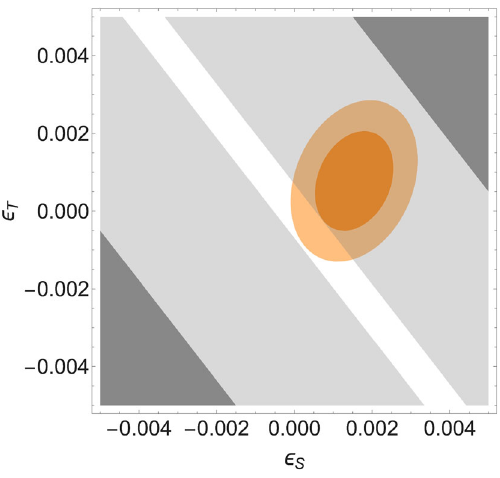
Fig. 3 Constraints on the Wilson coefficients (cid:15) S and (cid:15) T in the quark- level Lagrangian Eq. (2.5) at the scale μ (cid:16) 2 GeV, assuming ˜ (cid:15) X = 0 and marginalized over the remaining Wilson coefficients. We show the region preferred by the combination of low-energy precision measure- ments performed in Ref. [50] at 68% CL (darker orange), and 95% CL (lighter orange). We also show the region excluded by a hypothetical measurement of the D parameter in the 23 Mg beta decay with the uncer- tainty of 10 − 4 (darker shade of gray) and 10 − 5 (lighter shade of gray)